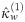
”Error-bar” plots of the Cohen’s kappa coefficient estimates (percent) for EXP2, P1 vs P2 ratings.The confidence intervals are at 95% confidence level and estimates corresponding to κ^w(1), κ^w(1) (DBR) and κ^w(1) (IR) are in red, green and blue, respectively.